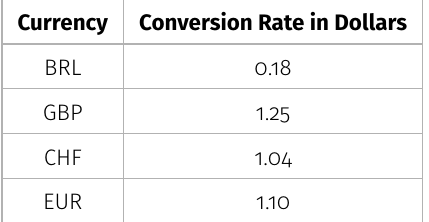
Table I. Conversion rate to dollars